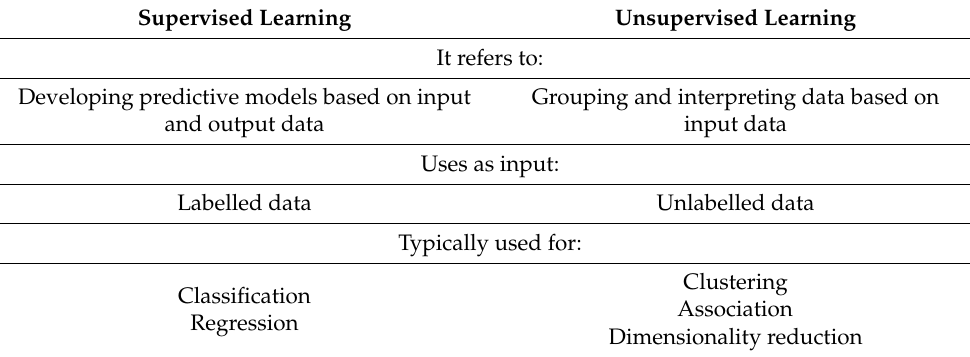
Table 4. Supervised vs unsupervised